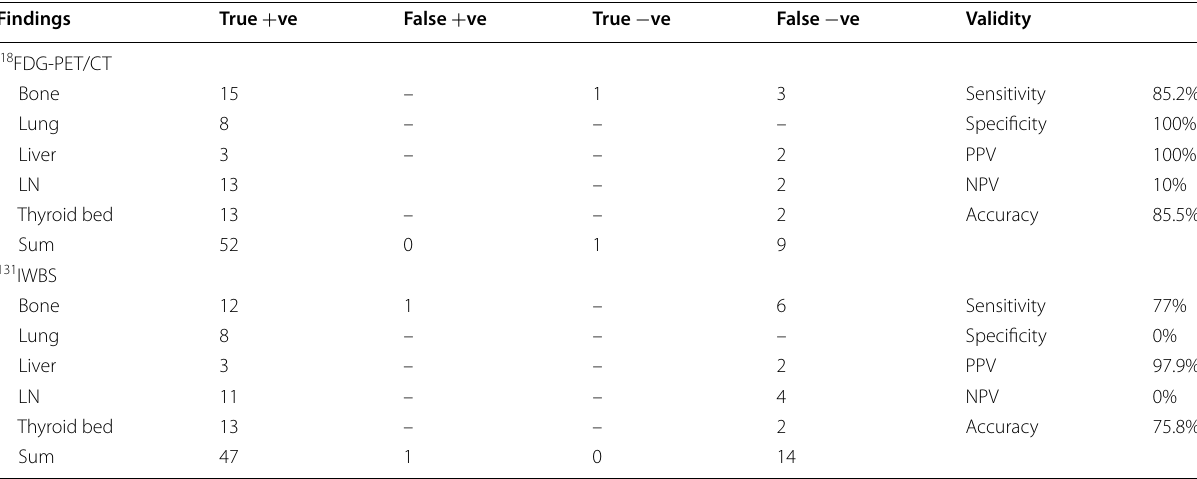
Table 5 Diagnostic performance of 18 FDG-PET/CT and 131 IWBS based on organ analysis in relation to histopathological results, conventional radiological tools and lesion behavior overtime